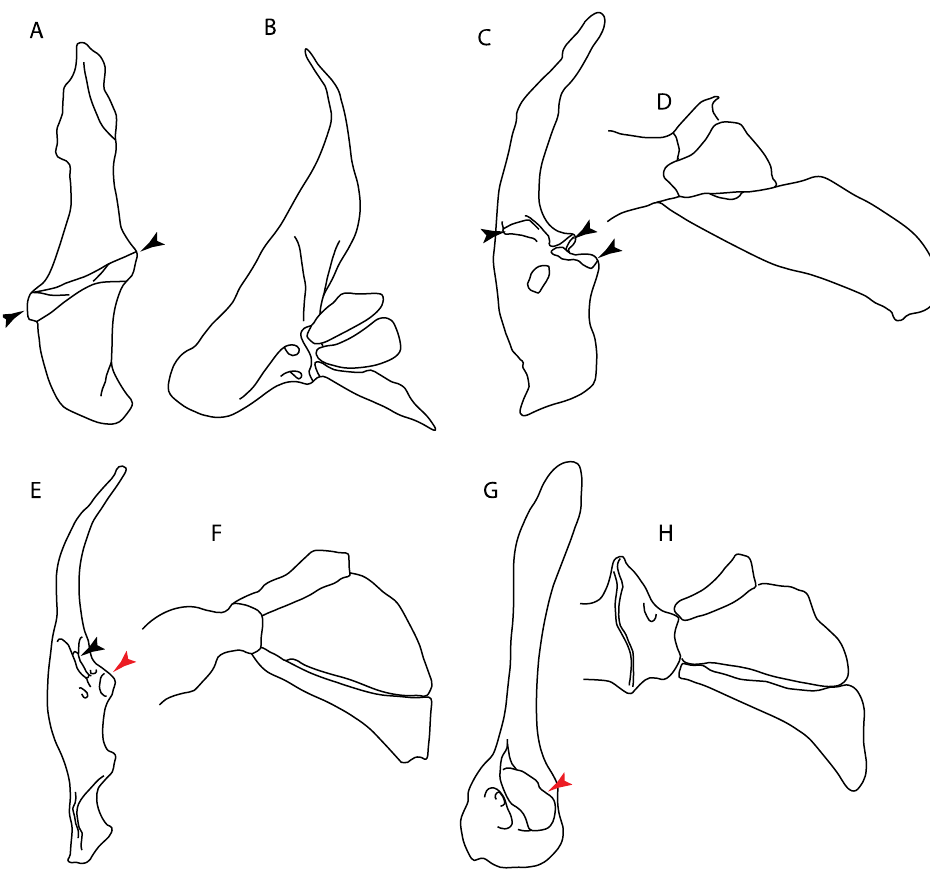
Figure 36. Interpretative drawings of the lateral face of the scapulacoracoid and the pectoral-fin supports in dorsal view. State (0): ( A , B ) † Tribodus limae (AMNH FF 13958) redrawn and modified from Lane and Maisey Text-Figures 5B and 9B in [105]; ( C , D ) Mustelus canis (ANSP 178683) redrawn and modified from da Silva and de Carvalho Text-Figure 30C,F in [8]. State (1): ( E , F ) Squalus megalops (MZUSP 110973) redrawn and modified from da Silva and de Carvalho Text-Figure 25C,G in [8]. State (2): ( G , H ) Heterodontus francisci (MZUSP 112022) redrawn and modified from da Silva and de Carvalho Text-Figure 1D,H in [8]).